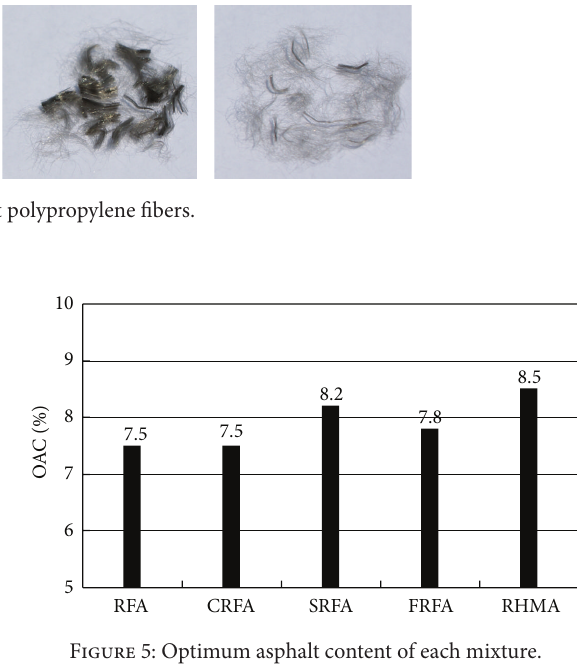
Figure 3: Gradation of RAP and aggregate mixture.